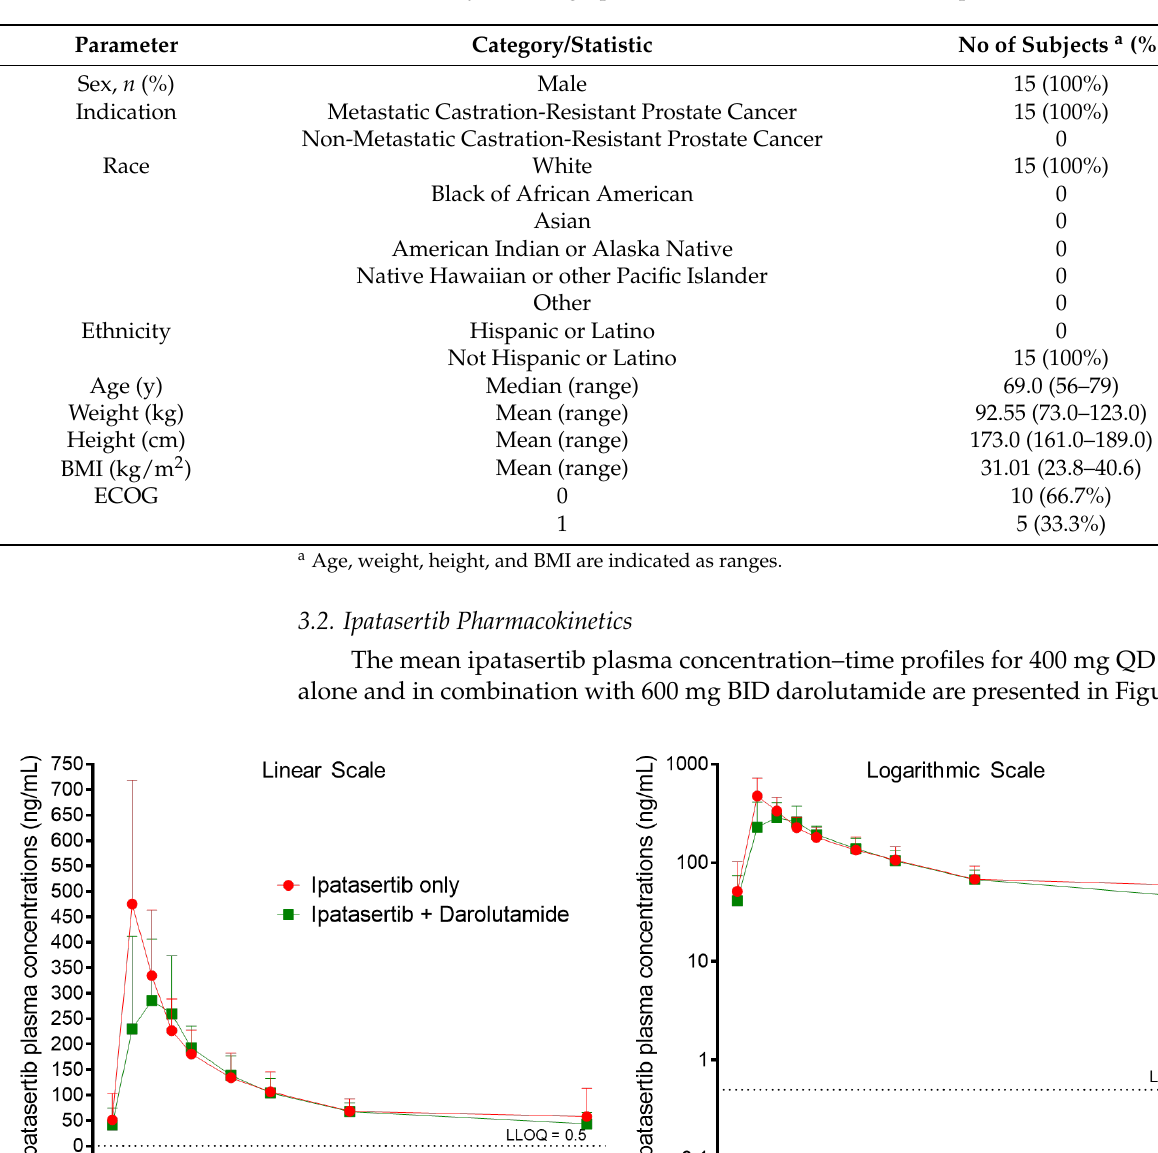
Table 1. Summary of demographics and baseline characteristics of patients enrolled in this study.